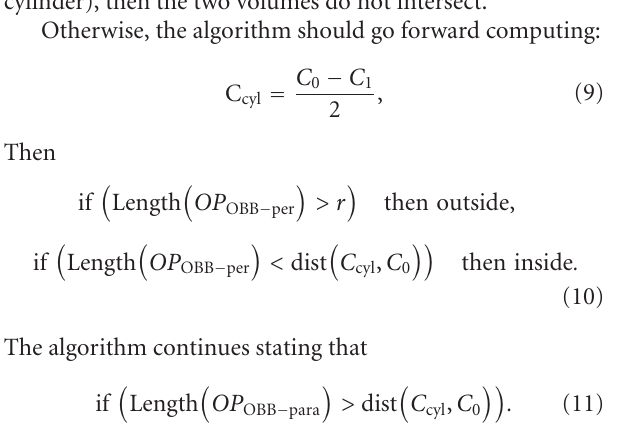
Figure 9: Principles of the intersection test between two